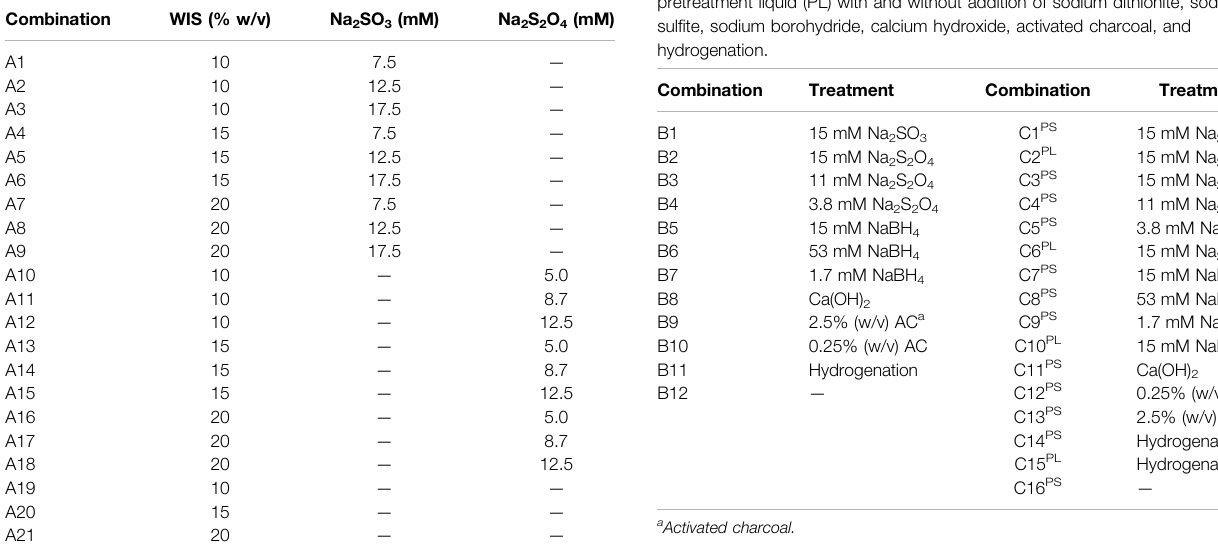
TABLE 1 | Experimental conditions for Series A with varying concentrations of sodium dithionite and sodium sul fi te and different content of WIS of pretreatment slurry.